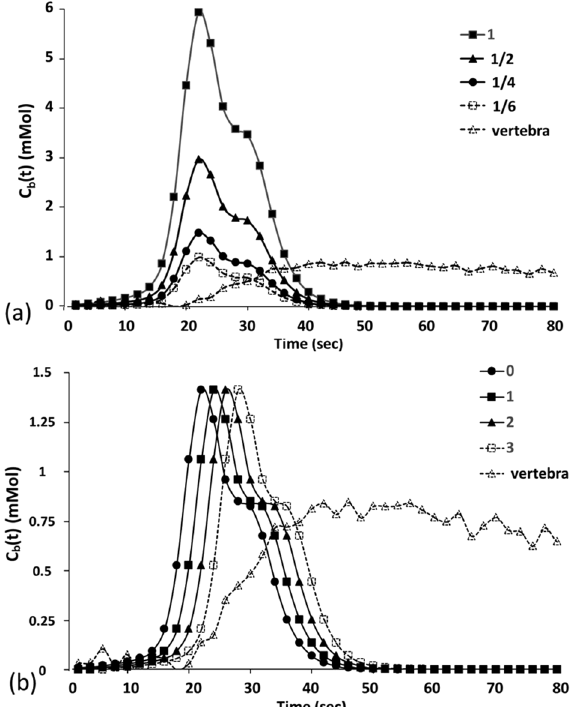
Figure 4. Simulation of arterial and vertebral concentration time curves generated using a typical aortic concentration time curve sample for one participant, showing the peak scaled by 1, 1/2, 1/4, and 1/6 ( a ) and the delay time adjusted by 0, 1, 2, and 3 time points ( b ). The first 80 of 440 s are